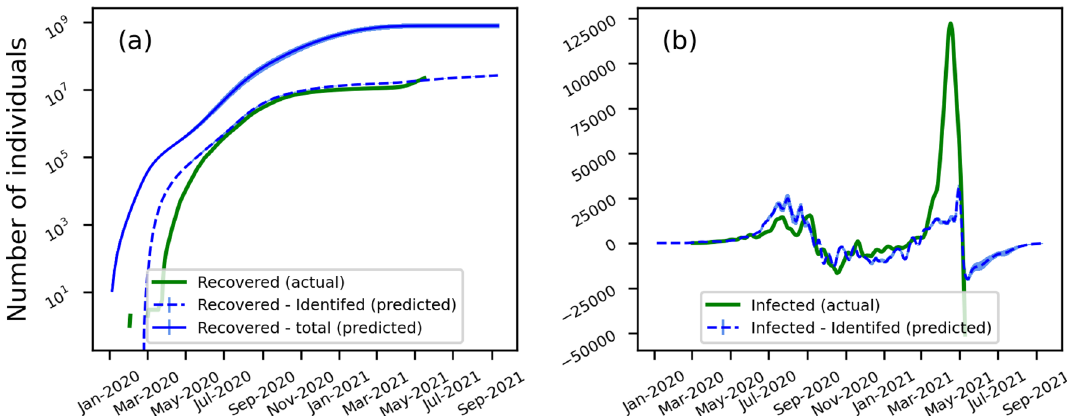
Figure 2. Actual and predicted number of ( a ) recovered and ( b ) change in infected COVID-19 cases in India. The shaded regions represent the standard error from 10 replicates.